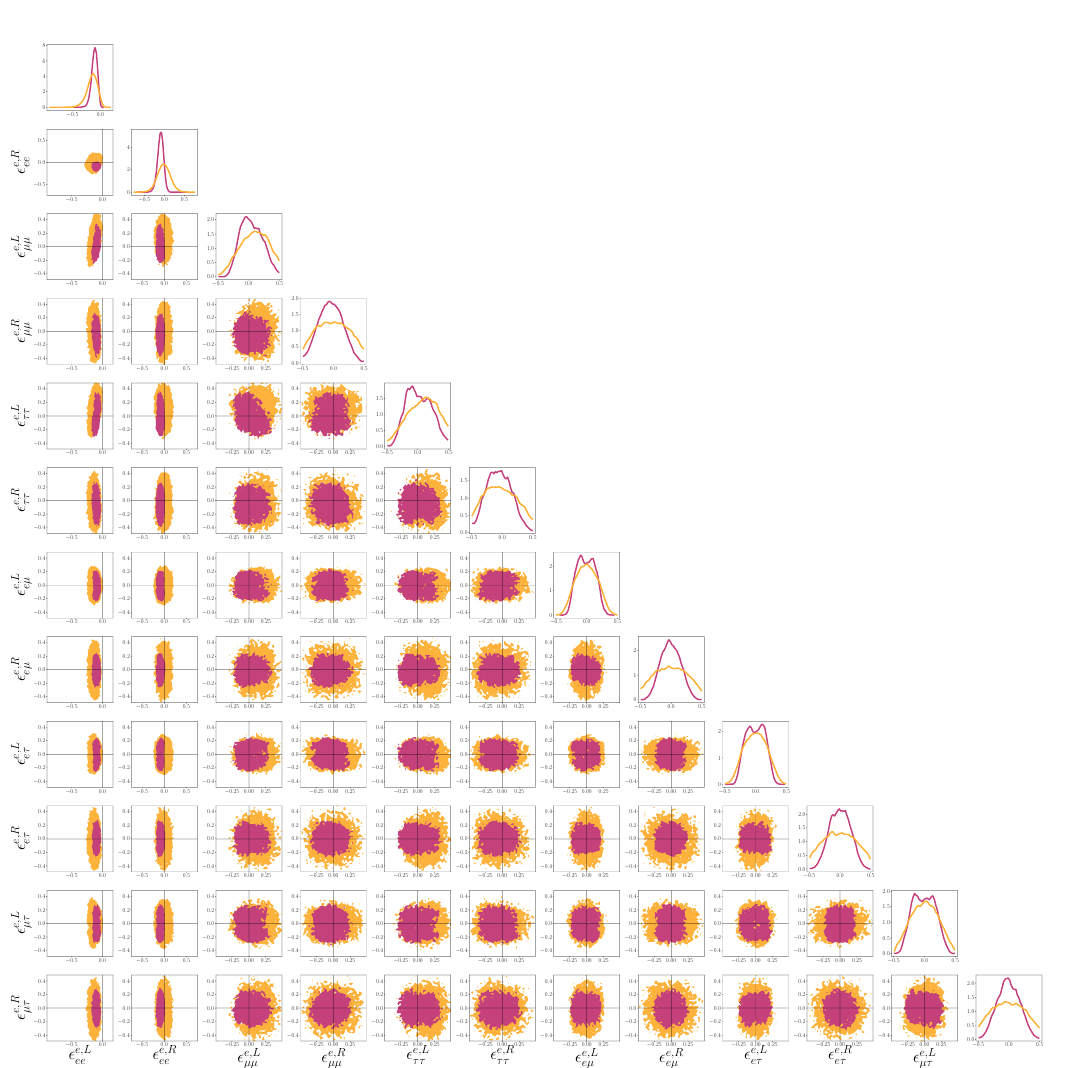
Figure 12 . 1-dimensional marginals and 68% credible contours for the 2-dimensional marginal projections are shown for left-handed and right-handed e -NSI ( (cid:15) e;L degrees of freedom. The distributions and contours for Borexino (yellow) and a future LXe DMD with priors from Borexino (magenta) are